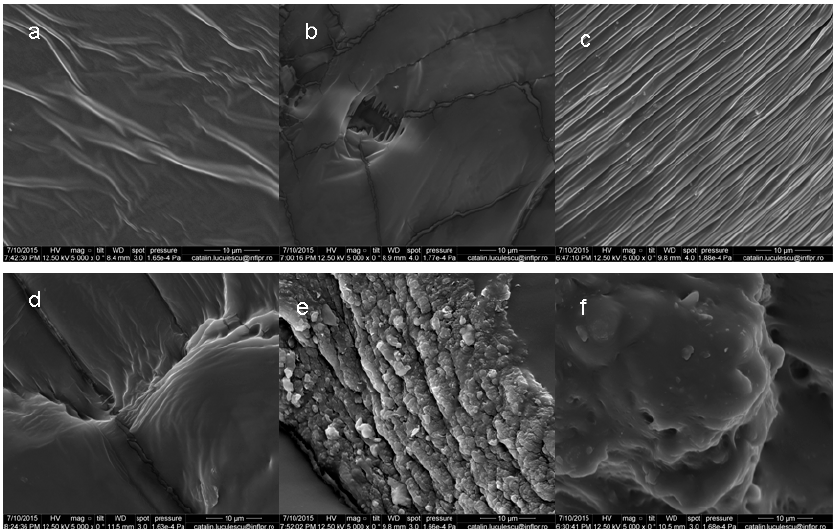
Figure 14. Surface morphology of: ( a ) NR; ( b ) NR/EDMA; ( c ) NR/ZDA; ( d ) NR/TMPT; ( e ) NR/TAC; and ( f ) NR/TAIC samples, irradiated at 300